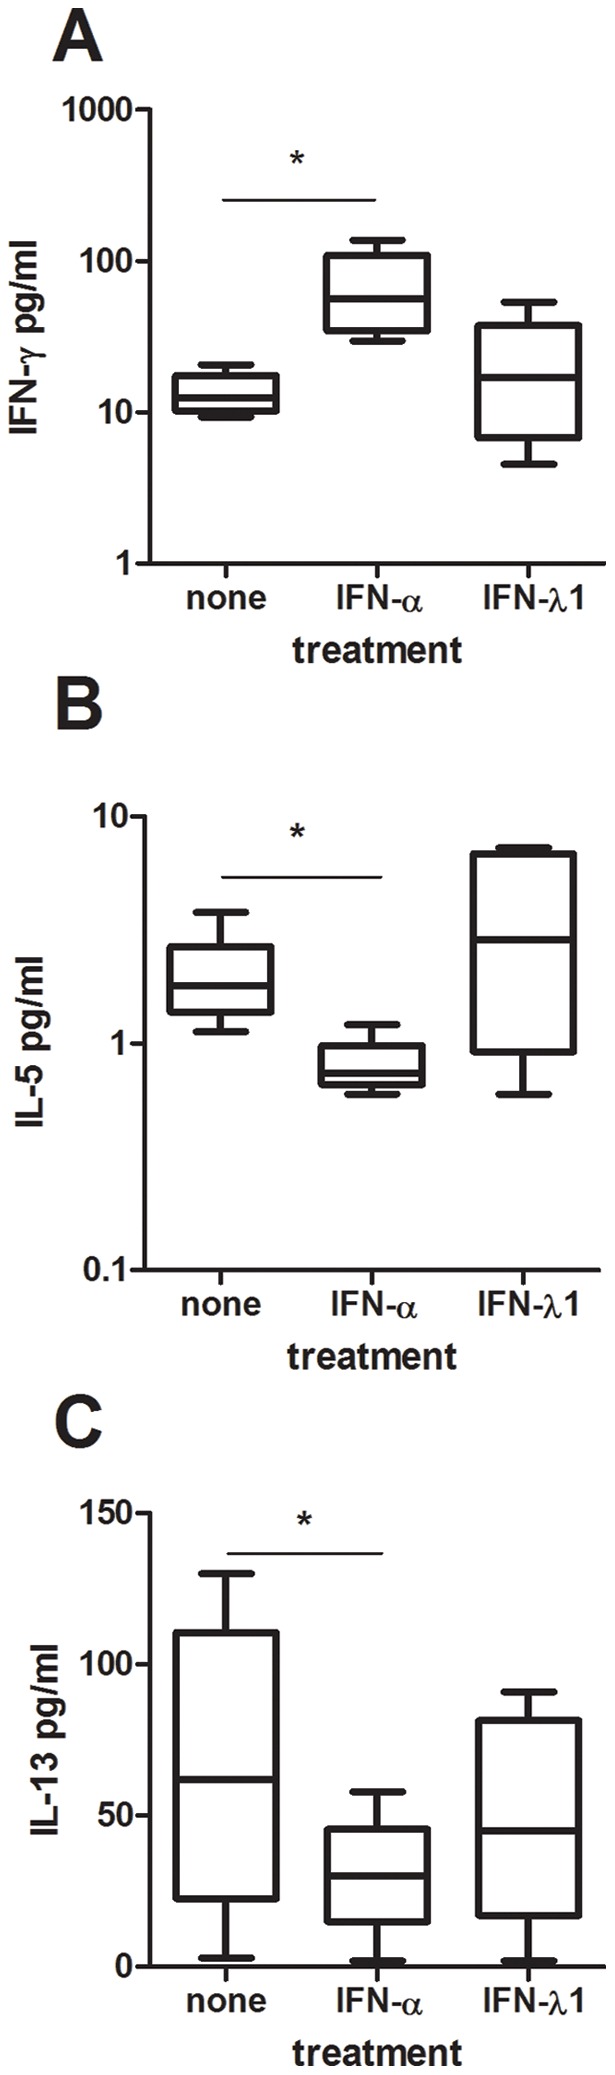
IFN-alpha but not IFN-lambda1 promote Th1 responses and block Th2 responses in activated cord CD4+ T-cells.Cord blood CD4+ T-cells were activated with anti-CD3 (A–B) or anti-CD3 and anti-CD28 (C) in the presence or absence of recombinant human IFN-alpha or IFN-lambda1. Supernatants were collected after 48 h and analyzed for IFN-gamma (A), IL-5 (B) and IL-13 (C) content. Data are expressed as medians and the 25% and 75% percentile (the boxes) with the minimum and maximum responses for n = 5. *  =  p<0.05 using ANOVA with Bonferroni's multiple comparison test.